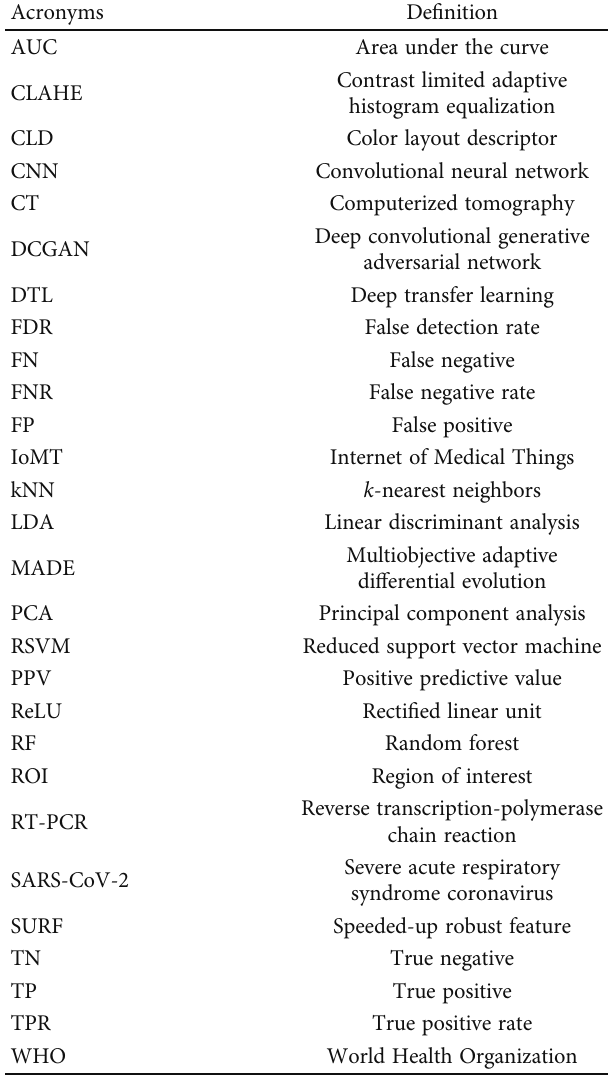
Table 1: The list of acronyms and their de fi